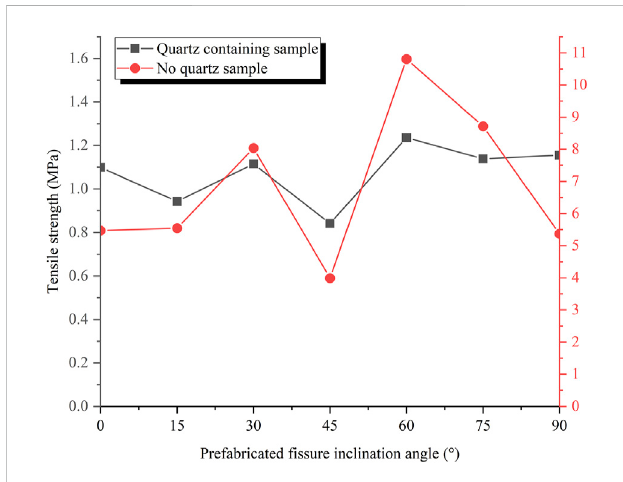
FIGURE 6 Effect of prefabricated fi ssure angle on the peak stress of the specimen.